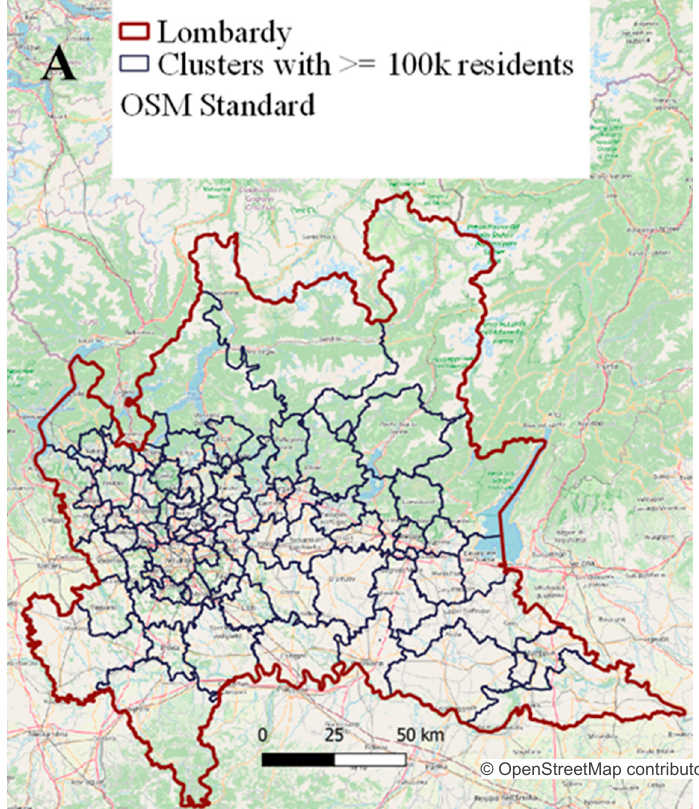
Figure 4 . Map of Lombardy region with overlapped the clusters of >100,000 residents, built around Figure 4. Map of Lombardy region with overlapped the clusters of > 100,000 residents, built around the the most inhabited cities, obtained with the proposed algorithm (see text for more details). most inhabited cities, obtained with the proposed algorithm (see text for more